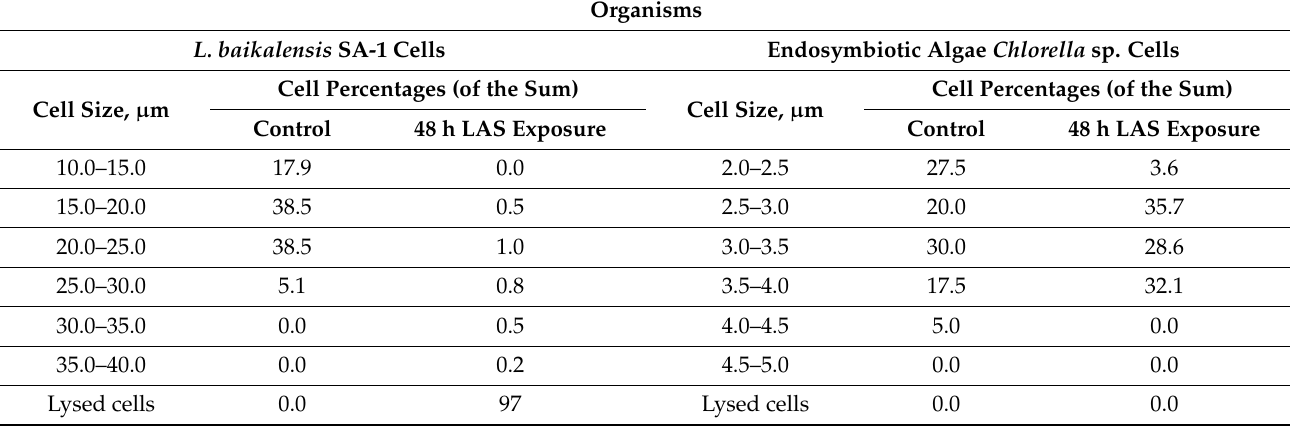
Table 1. Sponges and symbiotic algae cell sizes before and after anionic surfactant exposure.